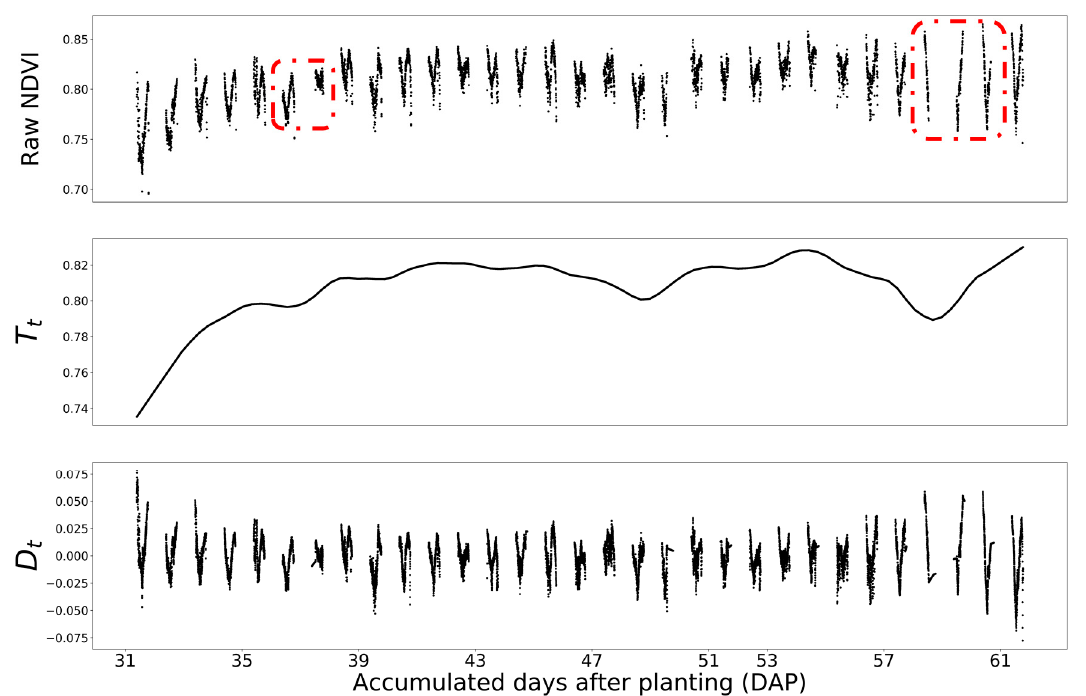
Figure 7. The NDVI of HN and Genotype B73 × Mo17 plot from V4 stage to the R1 stage. The raw NDVI plot was decomposed into the day-to-day trend ( T t ) and diurnal pattern ( D t ). The red boxes are the days with incomplete data measurements due to the extreme weather conditions, which are 36, 37, 58, 59 and 60 DAP.